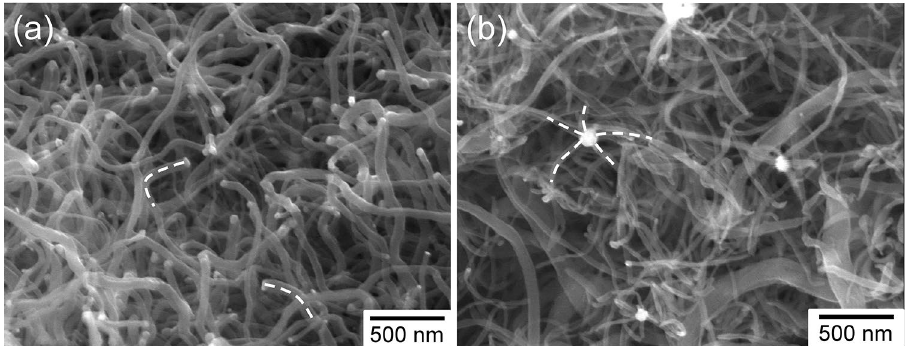
Fig. 1 Differences in the morphology of the MCs of a Ni100MC: One CNF was grown from one catalyst particle, b Ni80Cu20MC: multiple CNFs were grown from one catalyst